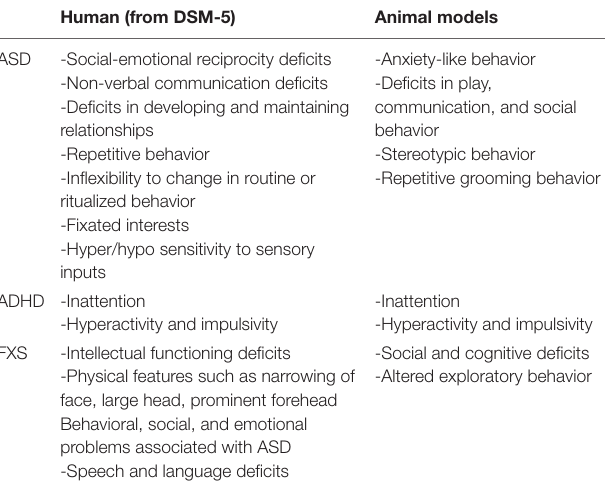
TABLE 1 | Comparison of NDD symptomology for humans and animal